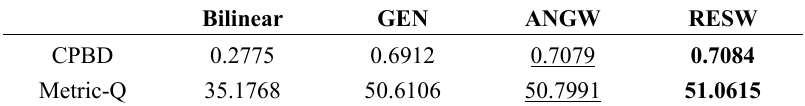
Table 8. CPBD and Metric-Q of the reconstruction image shown in Figure